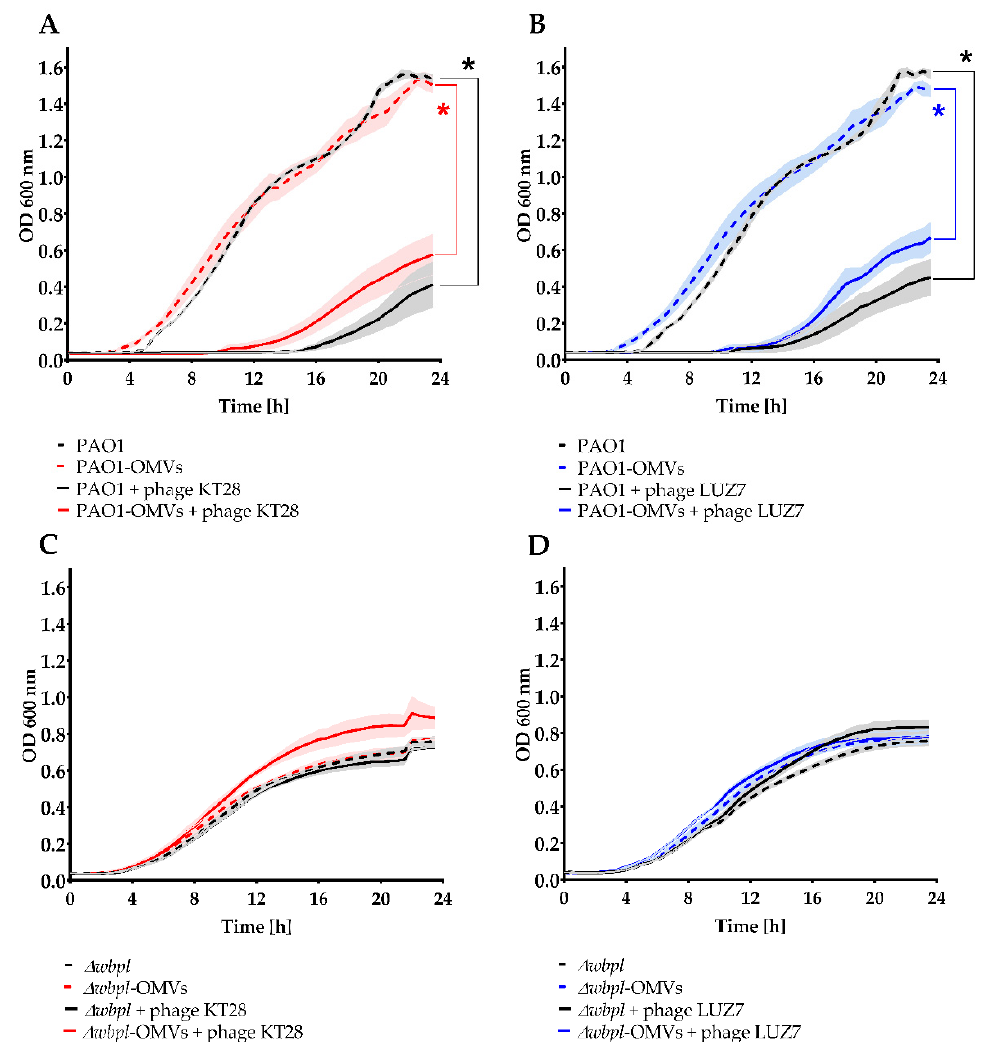
Figure 6. The OMVs association to P. aeruginosa cells as a potential sensitizer/disturbance agent to phage adsorption and propagation evaluated in bacterial culture growth kinetics. The PAO1 wild-type strain was used as the phage-sensitive host, whereas ∆ wbpl knock-out mutant deficient in O-antigens served as the phage-resistant strain. Bacterial growth was monitored by OD 600 measurement using a microplate reader for 24 h at 30 min intervals. The populations were treated with myovirus KT28 ( A , C ) or podovirus LUZ7 ( B , D ) at MOI = 1. The phage-uninfected culture without the addition of OMVs was considered as the control. The curves were established on the average of two independent experiments measured in triplicates ± SEM bars. Statistics were performed by Kruskal–Wallis ANOVA rang with pairwise AUC comparisons across groups: * p < 0.05.